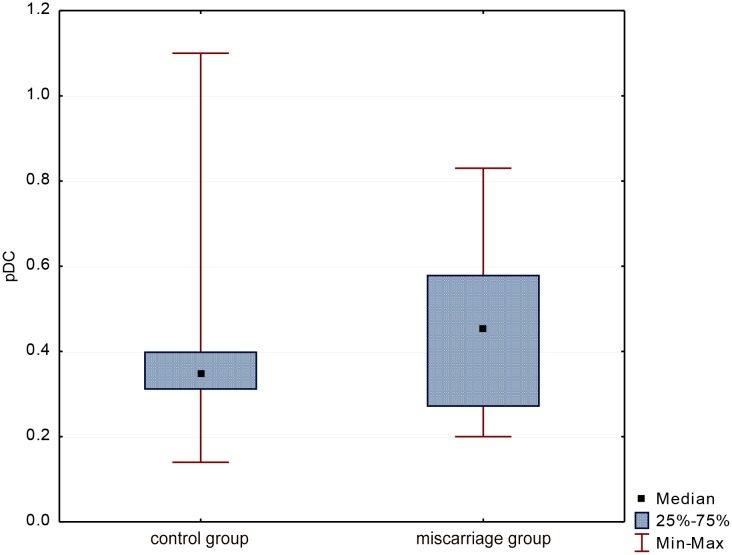
Evaluation of pDCs percentage in groups.